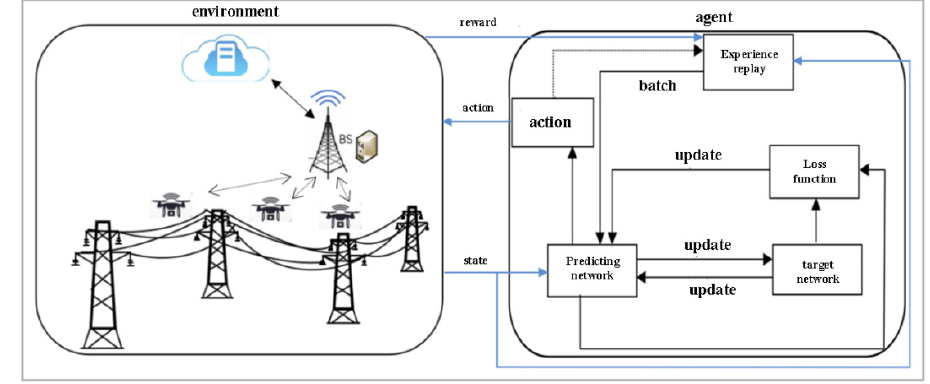
Figure 1. “UAV-edge-cloud” edge computing system model.